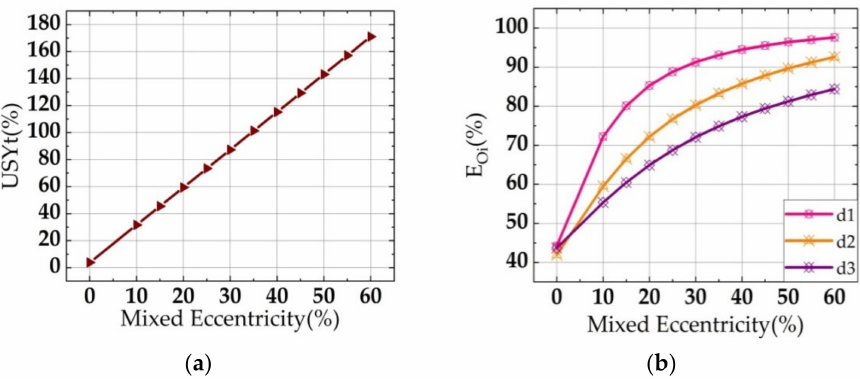
Figure 9. The influence of mixed eccentricity on the values of USYt and E Oi : ( a ) USYt ; ( b ) E Oi .